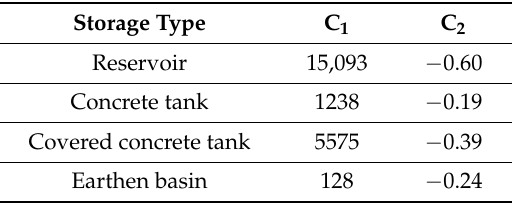
Table A1. Storage facilities cost